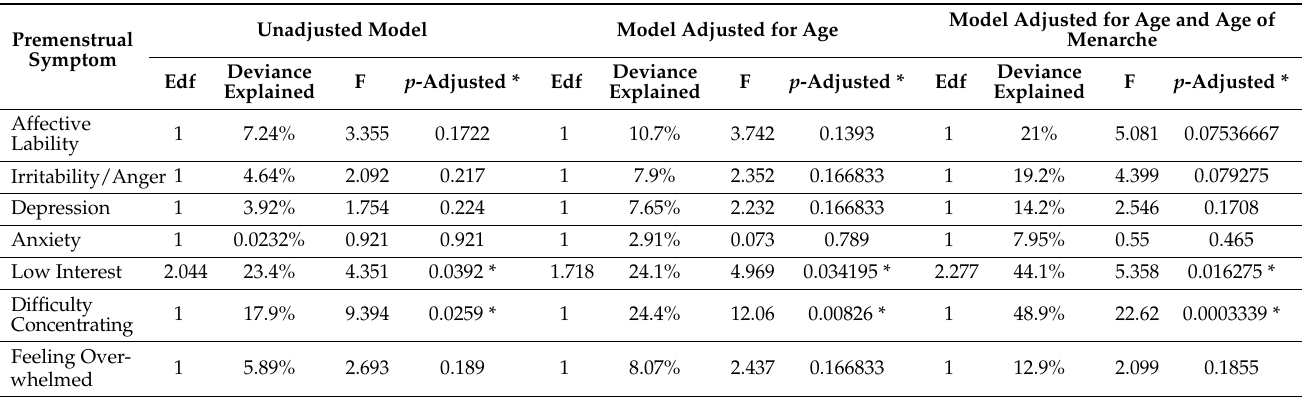
Table 3. Results of General Additive Modeling (GAM) for the Neuroticism-Anxiety Personality Trait in Relation to Premenstrual Symptoms.